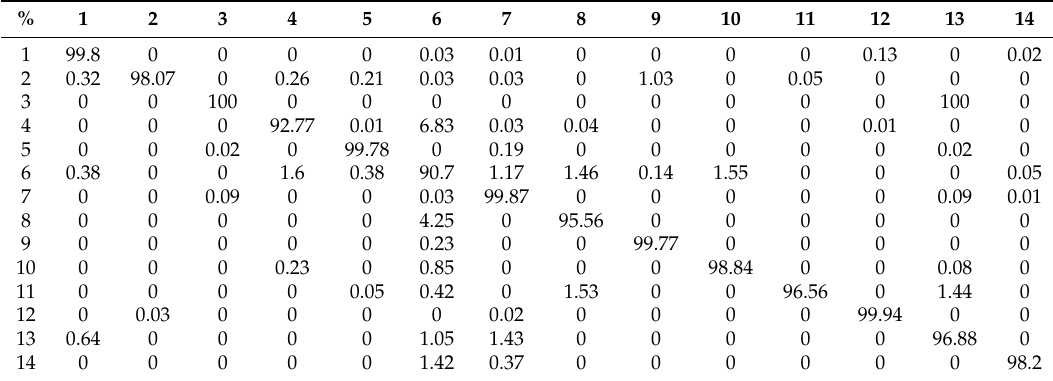
Table 4. The Confusion Matrix of CV-CAE+SPF.